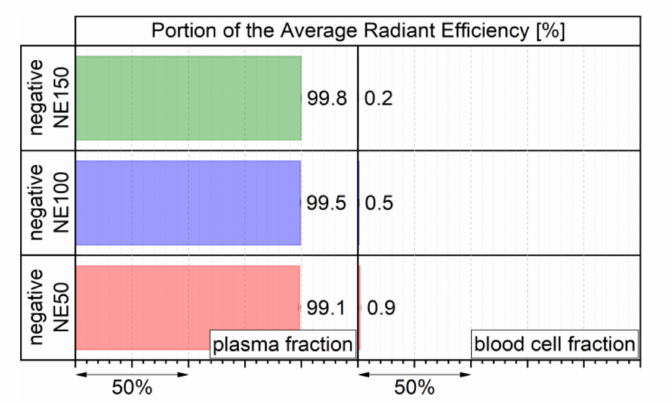
Figure 8. PARE in plasma and blood cell fractions after 4 h of incubation with the three negatively surface-charged nanoemulsions, determined by three individual incubated